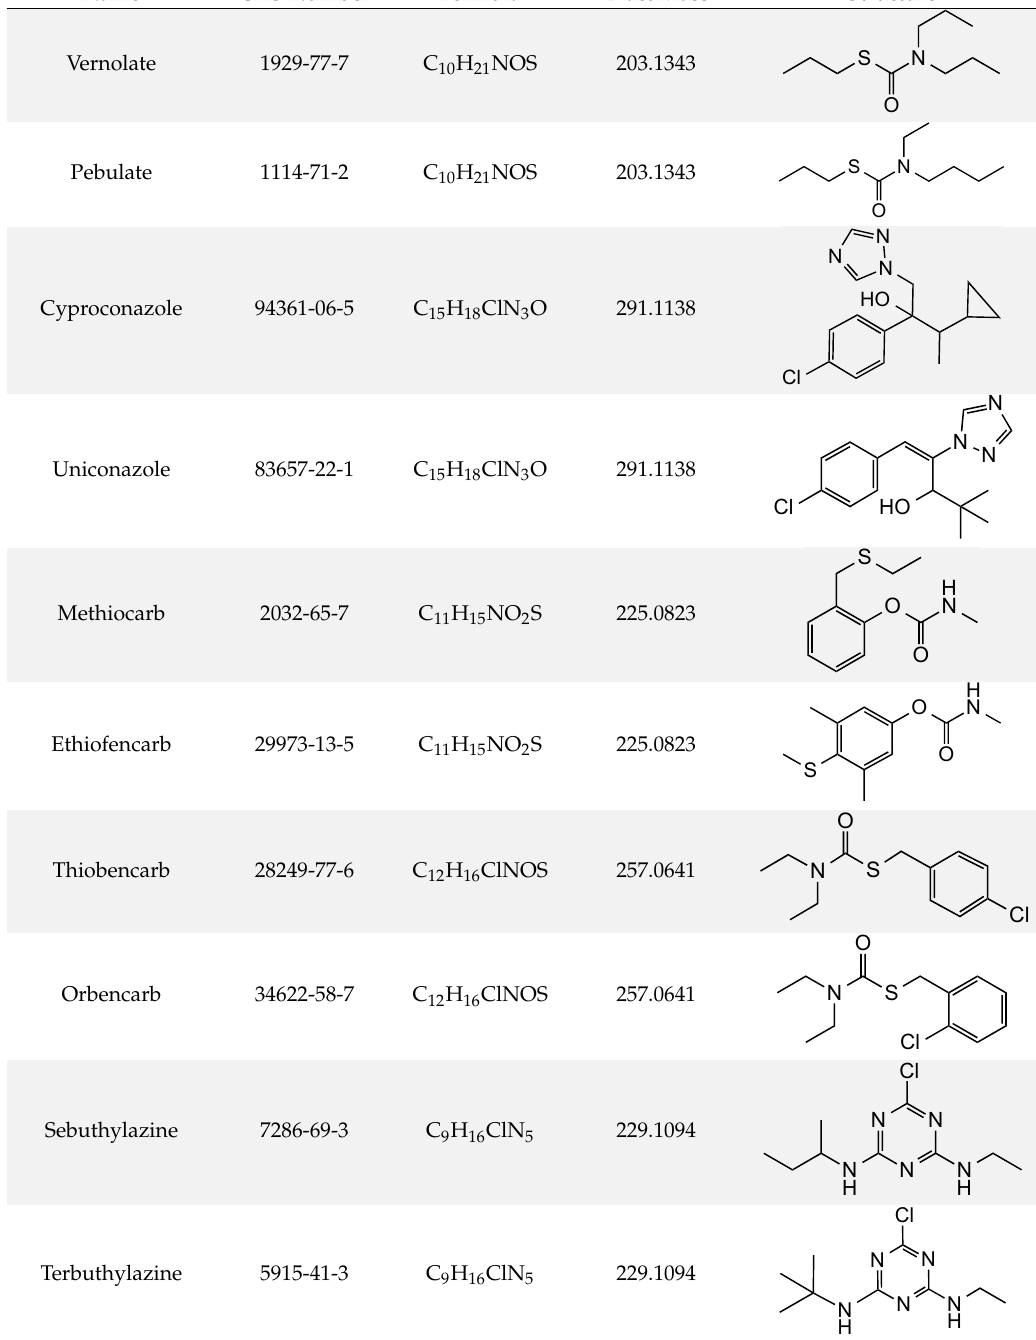
Table 1. Isomeric structures of studied pesticides.